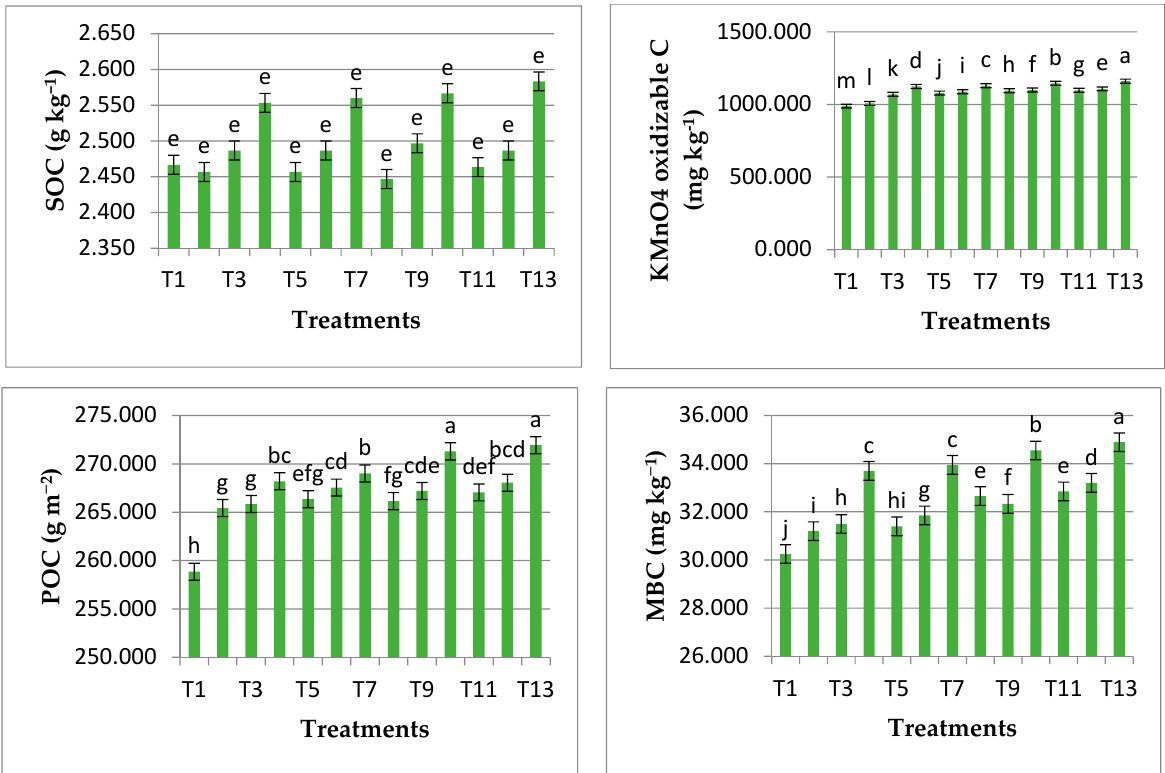
Figure 4. Effect of different treatments on various soil carbon fractions. Mean values with different letters differ significantly ( p < 0.05).